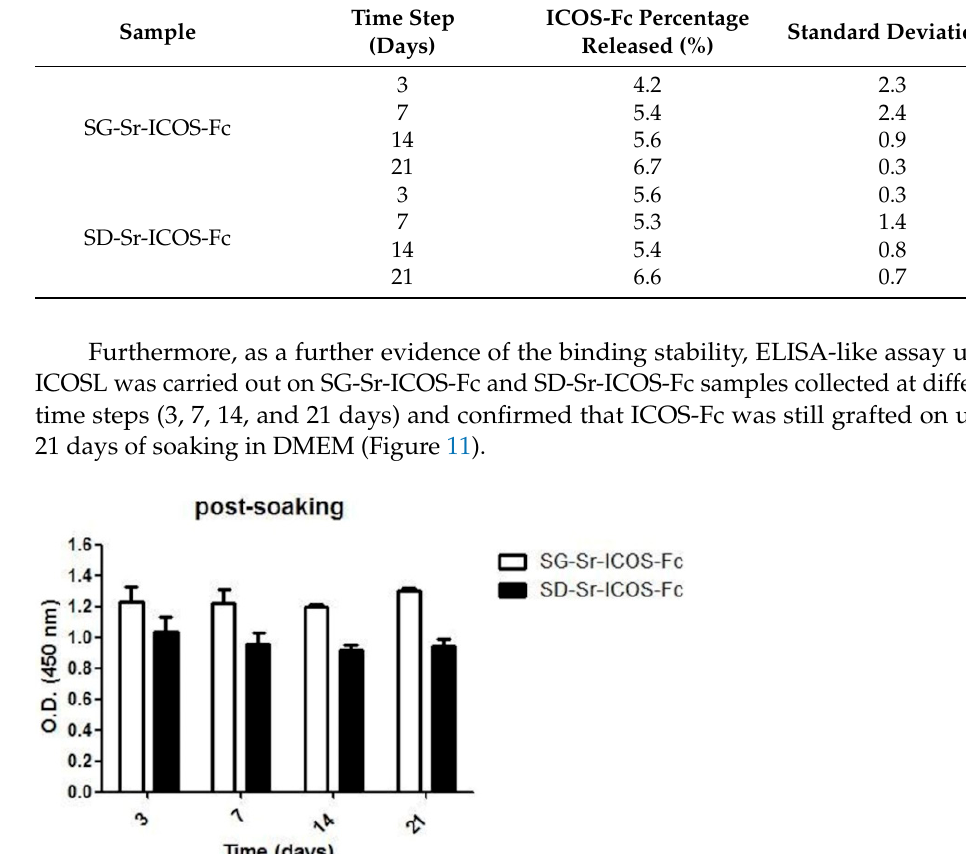
Table 2. Stability test of ICOS-Fc binding to MBG surface. The amount of ICOS-Fc released was evaluated for both SG-Sr-ICOS-Fc and SD-Sr-ICOS-Fc at time steps of 3, 7, 14 and 21 days. Sample